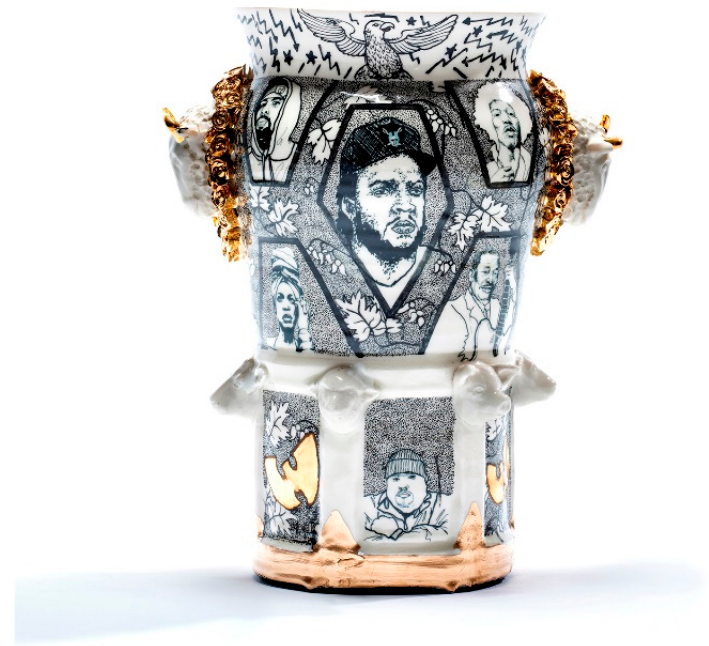
Figure 6. A Century of Black Music, 2018 , Porcelain and china paint, 13 × 9 × 16 in. Image by KeneK Photography, courtesy of Wexler Gallery.